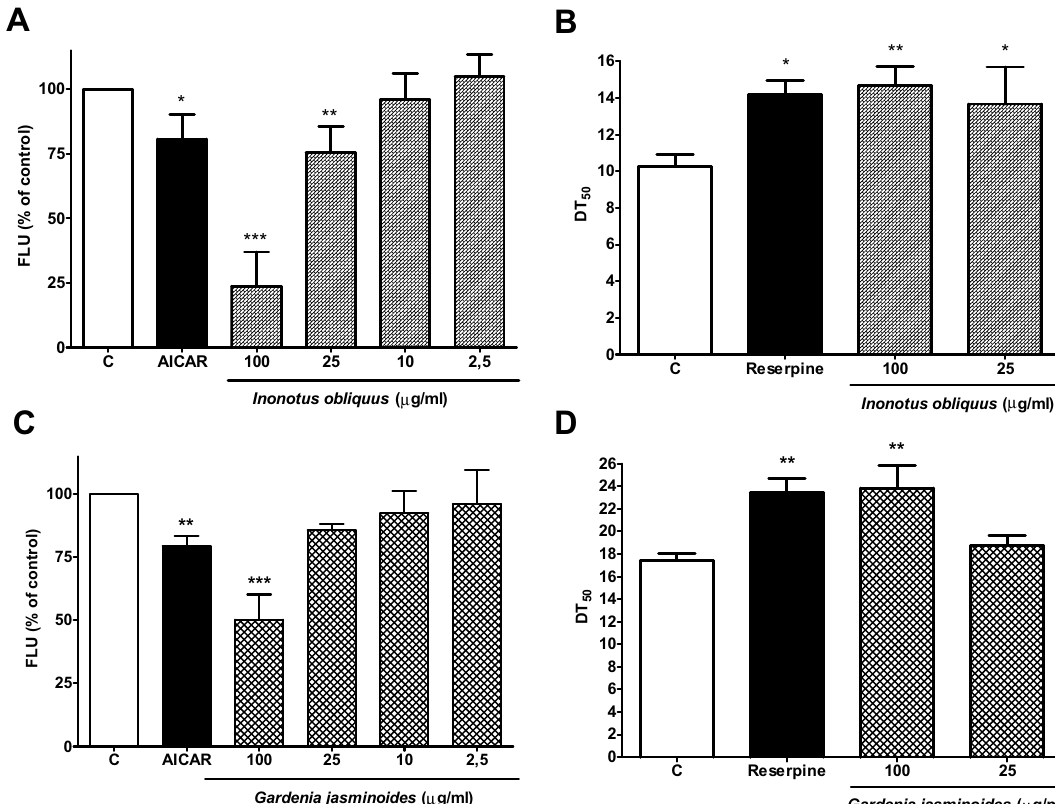
Figure 5. Effect of I. obliquus and G. jasminoides extracts on Nile red fluorescence (A, C) and survival (B, D) of C. elegans. Nile red assay ( A , C ): Vital Nile red fluorescence of C. elegans treated with control, AICAR (100 μM) and extracts of I. obliquus ( A ) and G. jasminoides ( C ). Bars represent the mean fluorescence intensities of at least three independent experiments expressed as % of control worms ± SD. Significance was assessed by One-Way